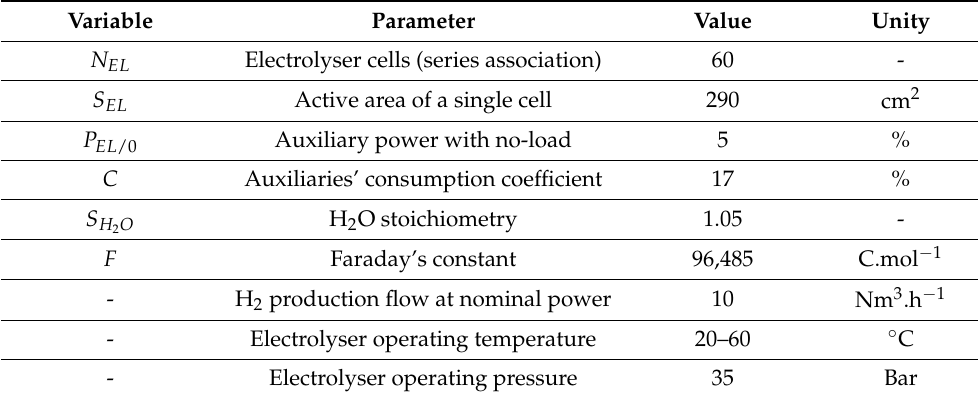
Table 3. Technical parameters for the electrolyser subsystem [20,57,58].